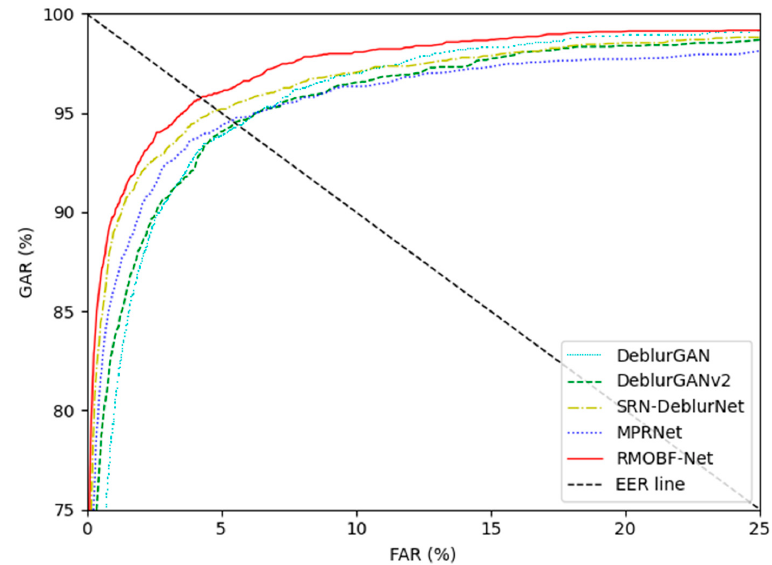
Figure 20. ROC curves of finger-vein recognition with SDU-DB for scheme 4 by various restoration methods (random motion blur and optical blur with intensity 19 × 19 (Gaussian filter size) and 19 (Gaussian filter standard deviation)).